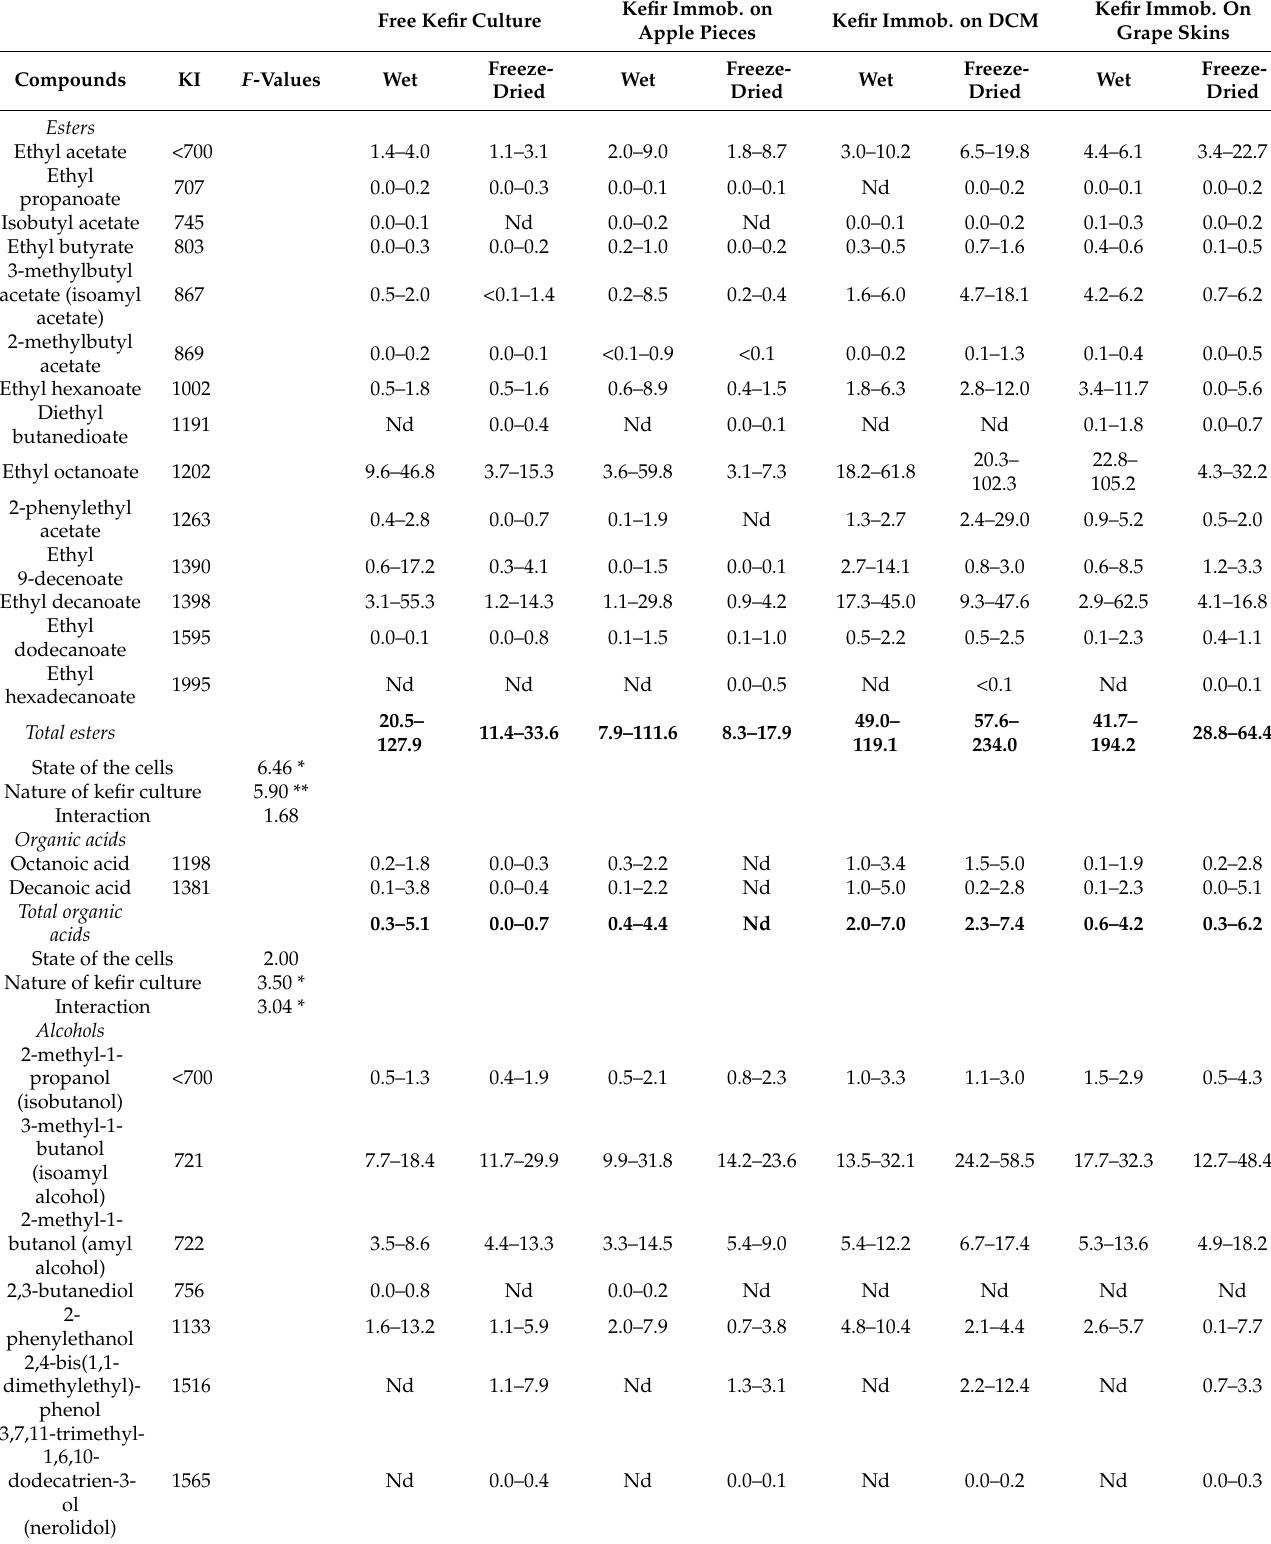
Table 4. Effect of cell immobilization and freeze-drying on minor volatile compounds (mg/L) identified in semi-dry and sweet low alcohol wines produced by kefir culture at 37 ◦ C using HS-SPME GC/MS analysis. Volatiles were semi-quantified using 4-methyl-2-pentanol as internal